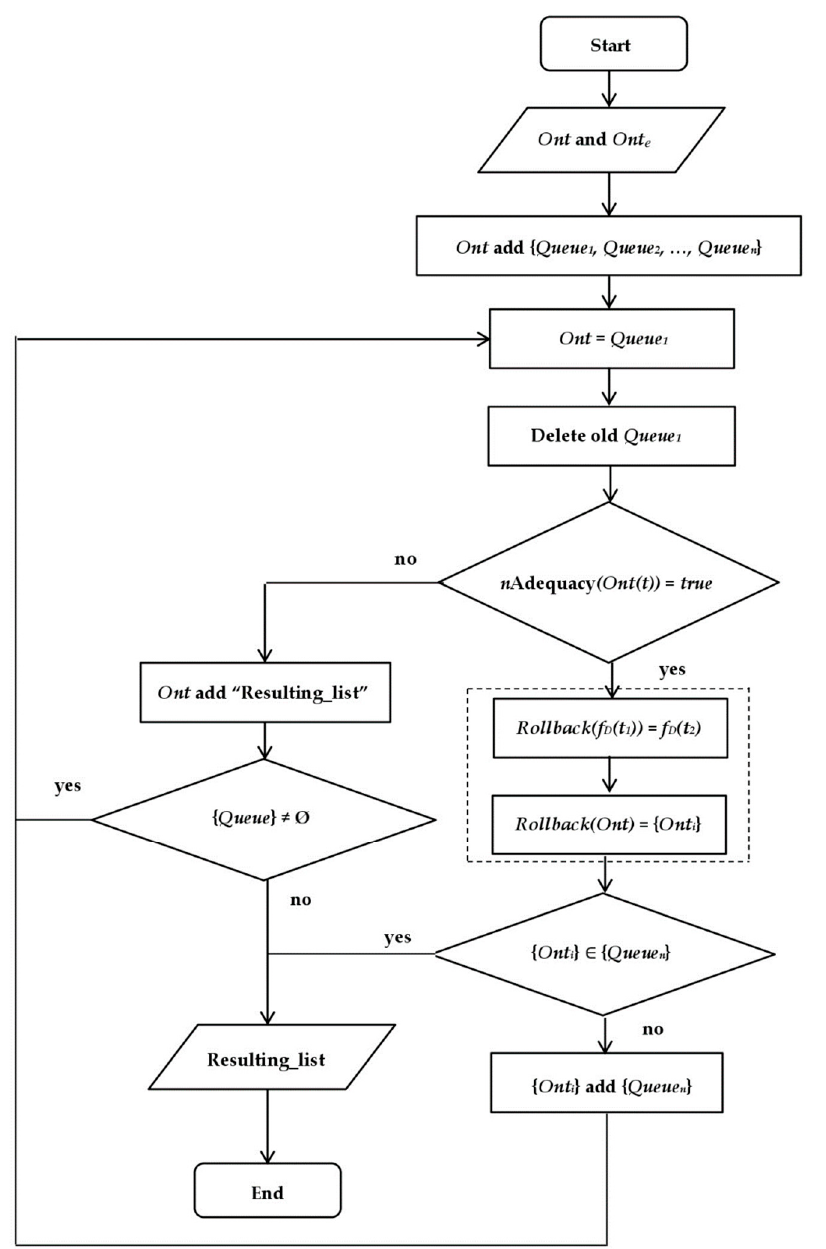
Figure 6. Flow chart of searching the upper limit of adequacy of ontology development.